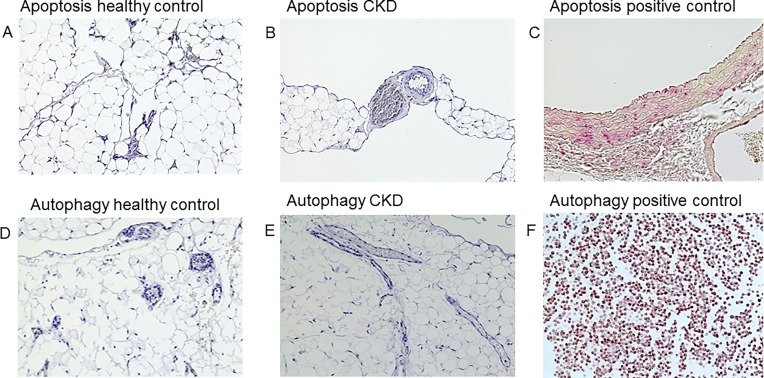
Apoptosis and autophagy in omental biopsies of children with CKD 5 and controls.Caspase-3 staining reveals no apoptotic signal in either controls (A) or children with CKD (B); (C) positive control. Similarly, staining with LC3A/B antibody reveals no autophagy signal in either controls (D) or children with CKD (E); (F) positive control.